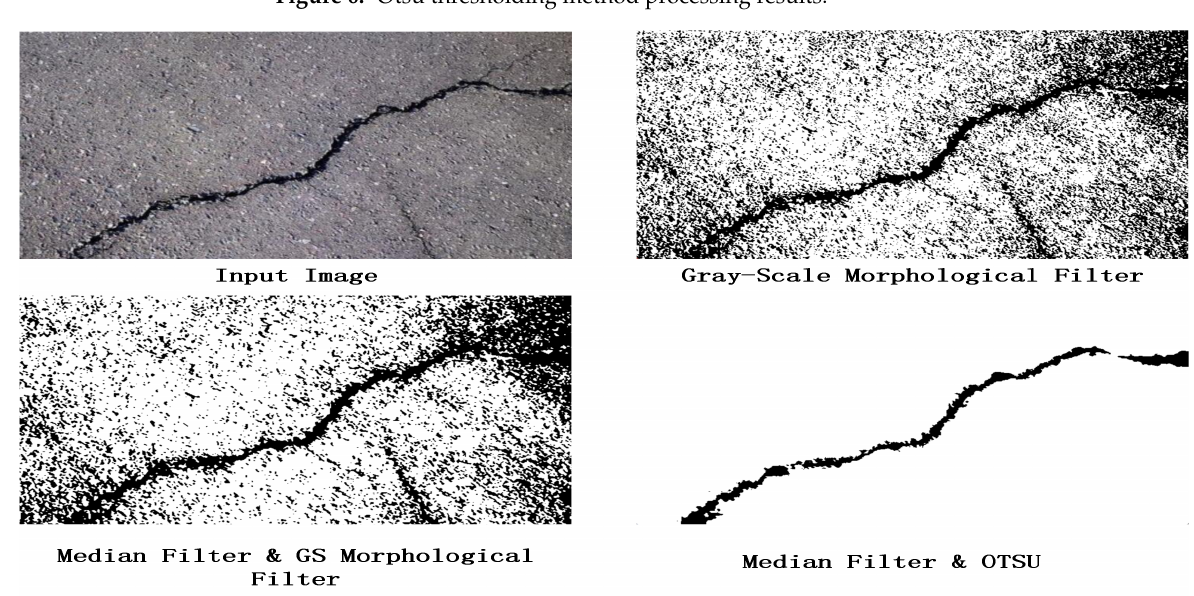
Figure 7. Feature extraction effect